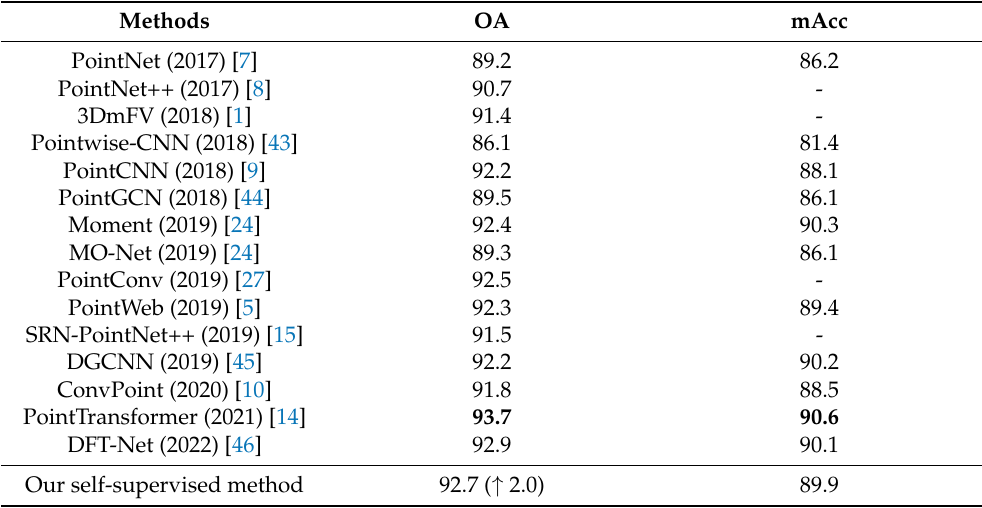
Table 1. Classification accuracy on ModelNet40. ↑ represents the improvement compared to the